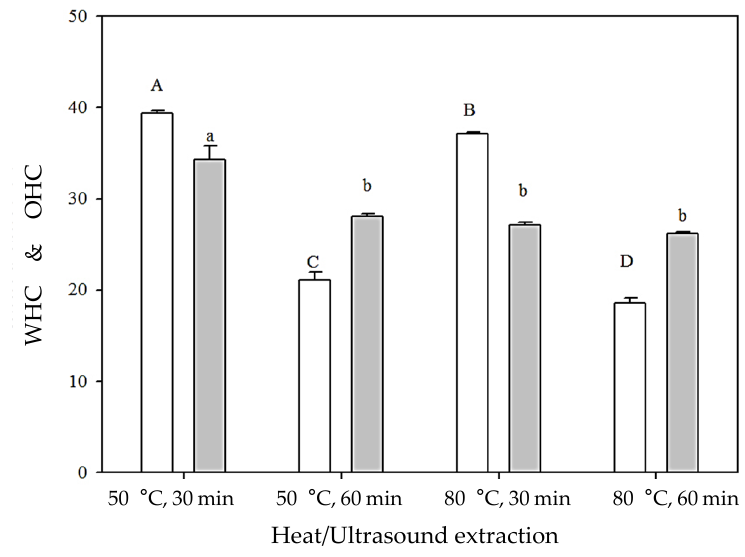
Figure 5. The water holding capacity (WHC, ) and oil holding capacity (OHC, ) of chia seed mucilage extracted by ultrasound in combination with heat. Error bars represent standard deviations. Means with different superscript capital letters and lowercase letters denote significant difference among WHC and OHC ( p < 0.05), respectively.